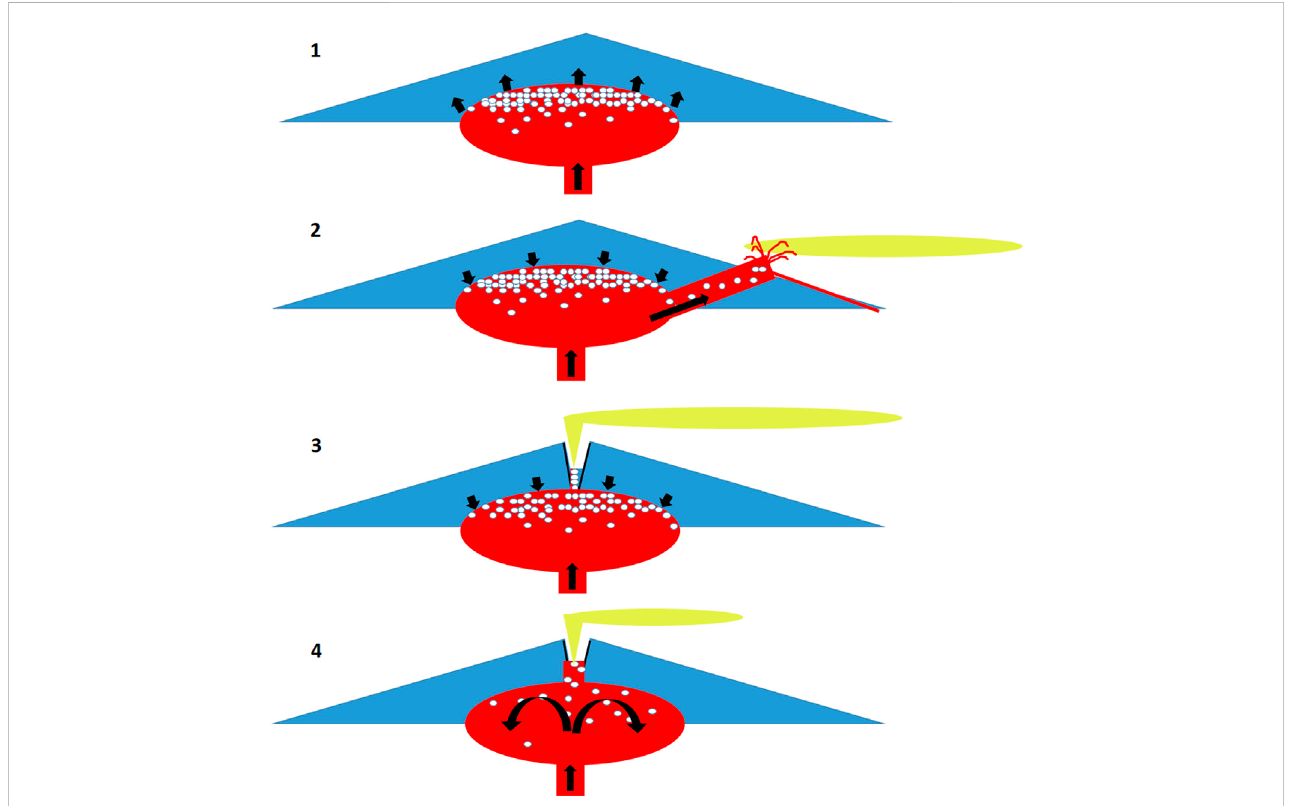
FIGURE 11 Schematic drawings of the four stage common sequence of lava lake formation at rift and hotspot volcanoes (not to scale, the size of the magma reservoir has been exaggerated). 1) Magma accumulation and gas segregation under a closed system condition. 2) Partial drainage of the storage area. 3) Openingofthesystemthroughtheformationofapitcrater.Asmallfoam-fed lavalakeproduces anintensedegassing butlow amountsofVRP.4)Exhaustion of the foam, establishment of classical magmatic convection, and growth of the lava